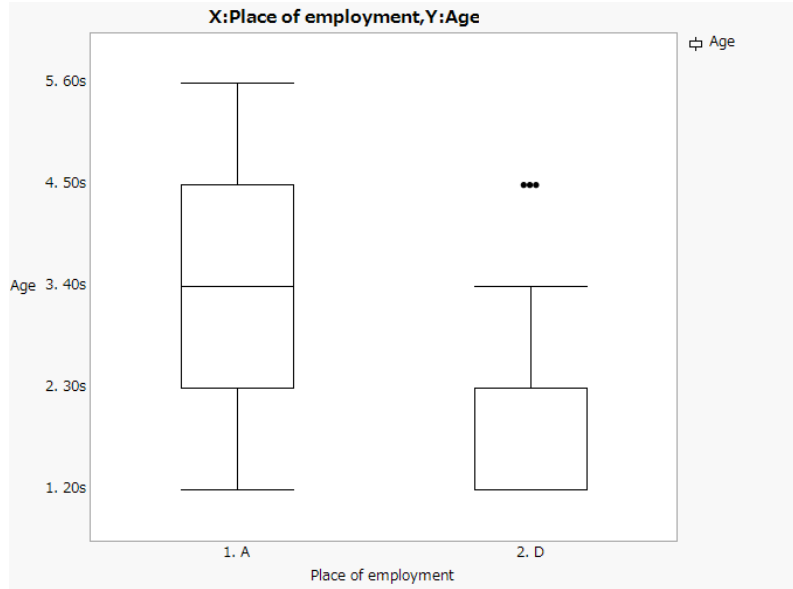
Figure 3. Box-and-whisker plots by age group.